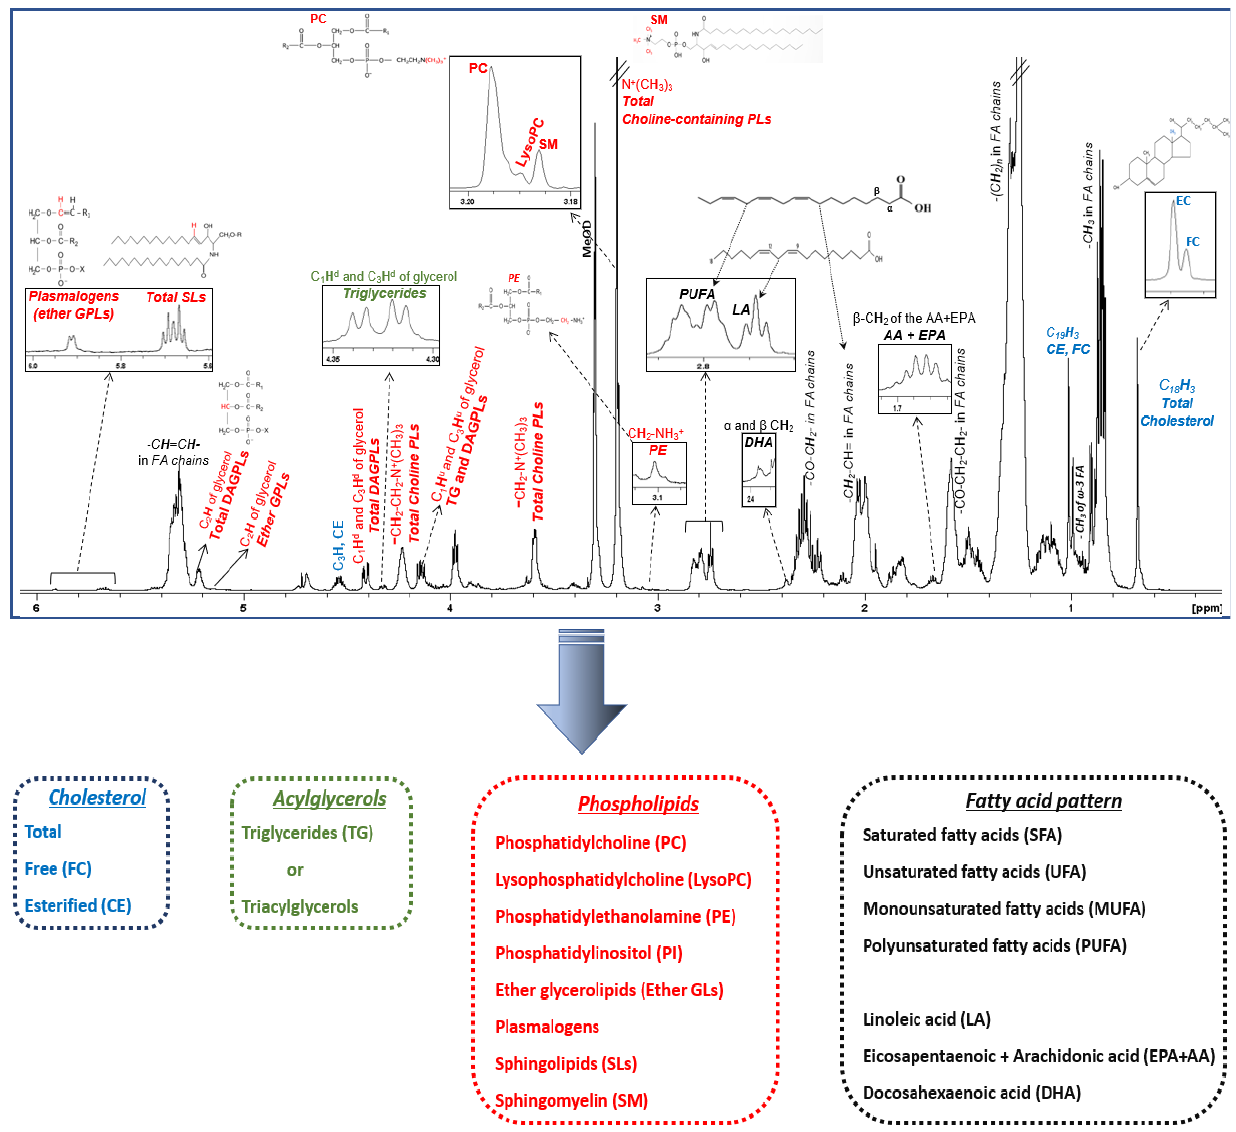
Figure 3. 1 H NMR spectrum of an HDL lipid extract. Figure is adopted from [63]. Peak assignments are summarized in Table 1.